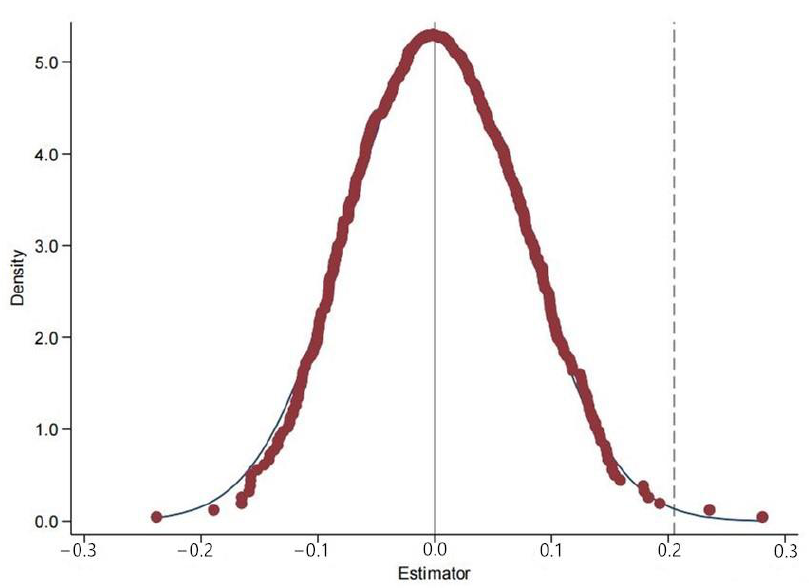
Figure 4. Land HSR and cropland abandonment: placebo test.